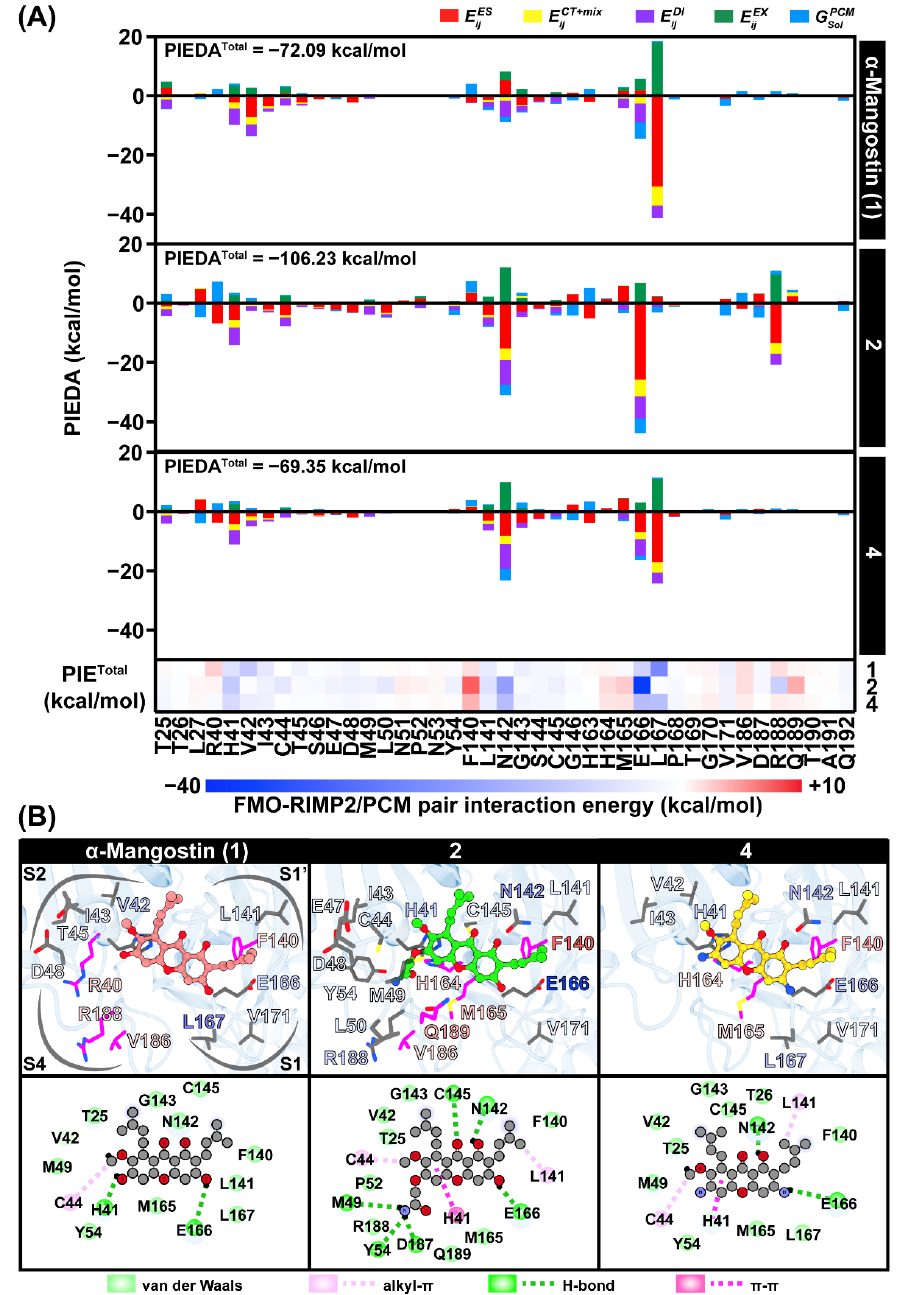
Figure 4. ( A ) Interaction energy profile of α -mangostin ( 1 ) and N -containing α -mangostin analogs 2 and 4 at the active site of SARS-CoV-2 3CL Pro calculated by FMO–RIMP2/PCM technique. Energy decomposition analysis (PIEDA) and total interaction energy (PIE Total ) are presented by stacked bar graph and grid diagram, respectively. ( B ) 3D ligand–protein interactions, where the key residues with PIE < − 2 kcal/mol and >1 kcal/mol are labeled and shaded according to PIE Total . 2D ligand–protein interactions drawn by BIOVIA Discovery Studio Visualizer program [41].